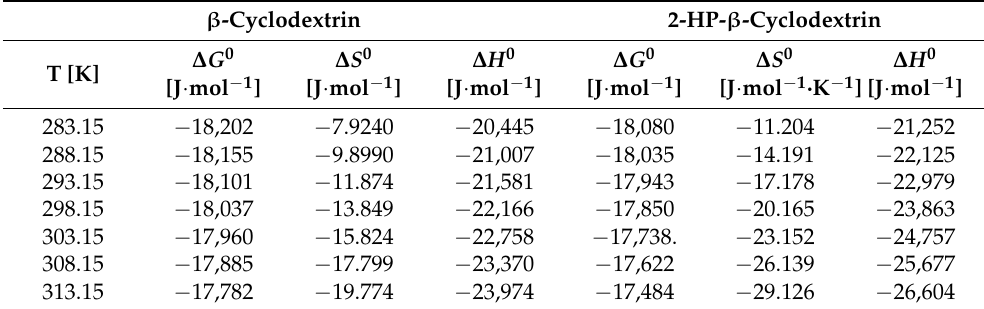
Table 8. The values of thermodynamic functions ∆ G 0 , ∆ S 0 , ∆ H 0 [J · mol − 1 ] for β -cyclodextrin and 2-HP- β -cyclodextrin with the salt of trans -ferulic